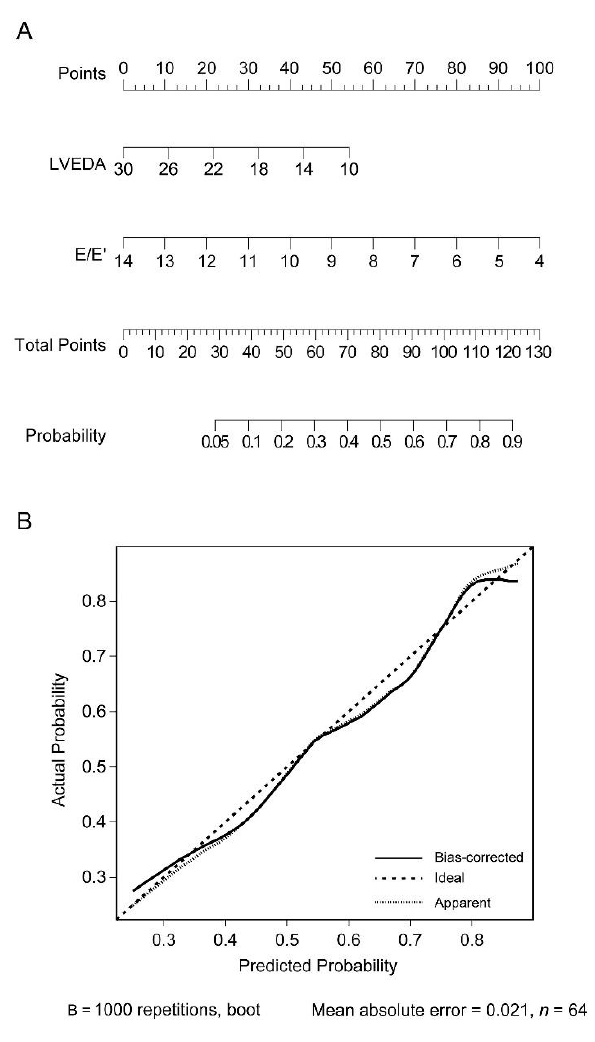
Figure 2. ( A ) Nomogram constructed with combination of left ventricular end-diastolic area (LVEDA) and the ratio of early mitral flow velocity to early diastolic velocity of the mitral annulus (E/E’). The p value of the Hosmer–Lemeshow goodness-of-fit test was 0.384. ( B ) Calibration plot comparing the actual and predicted probability of fluid responsiveness proposed by the nomogram with a mean absolute error of 0.021, n = 64.